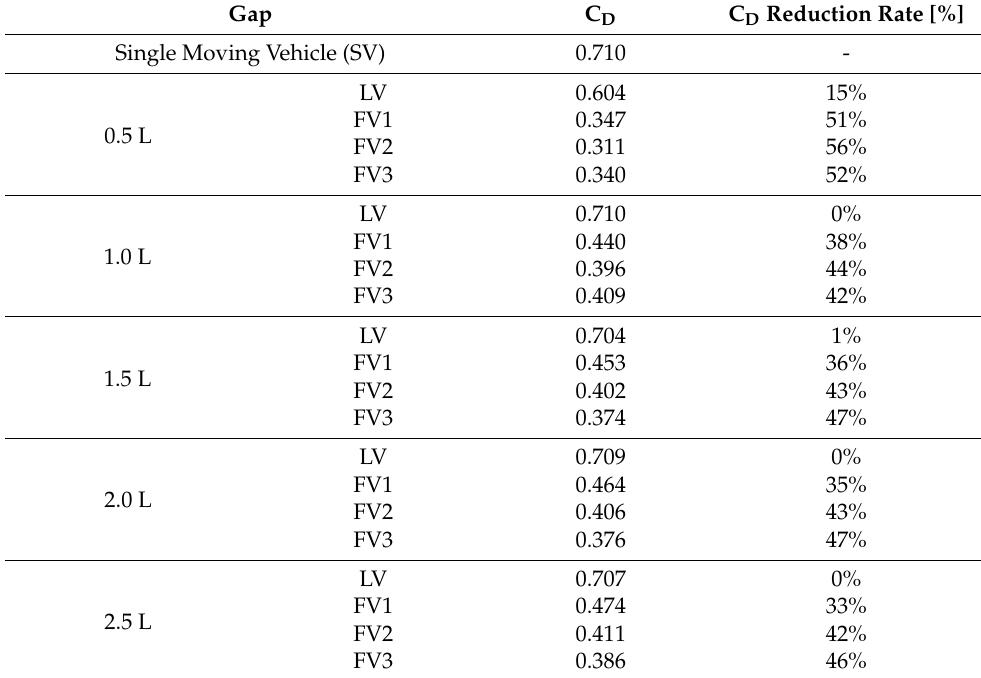
Figure 4. Variation in drag coefficient (C D ) of each model vehicle in platooning with the change in the gap.